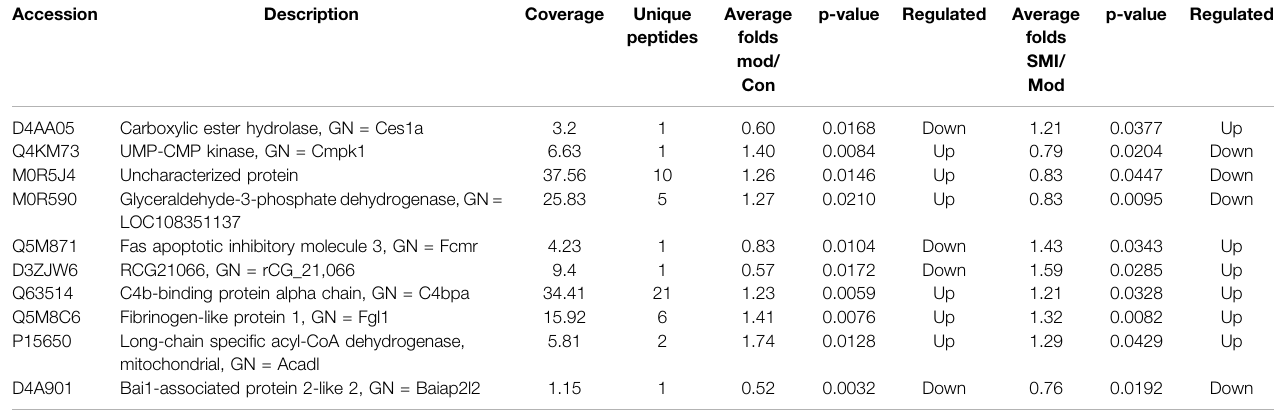
TABLE 3 | Common signi fi cantly differentially expressed proteins (DEPs) in Mod: Con and SMI: Mod.